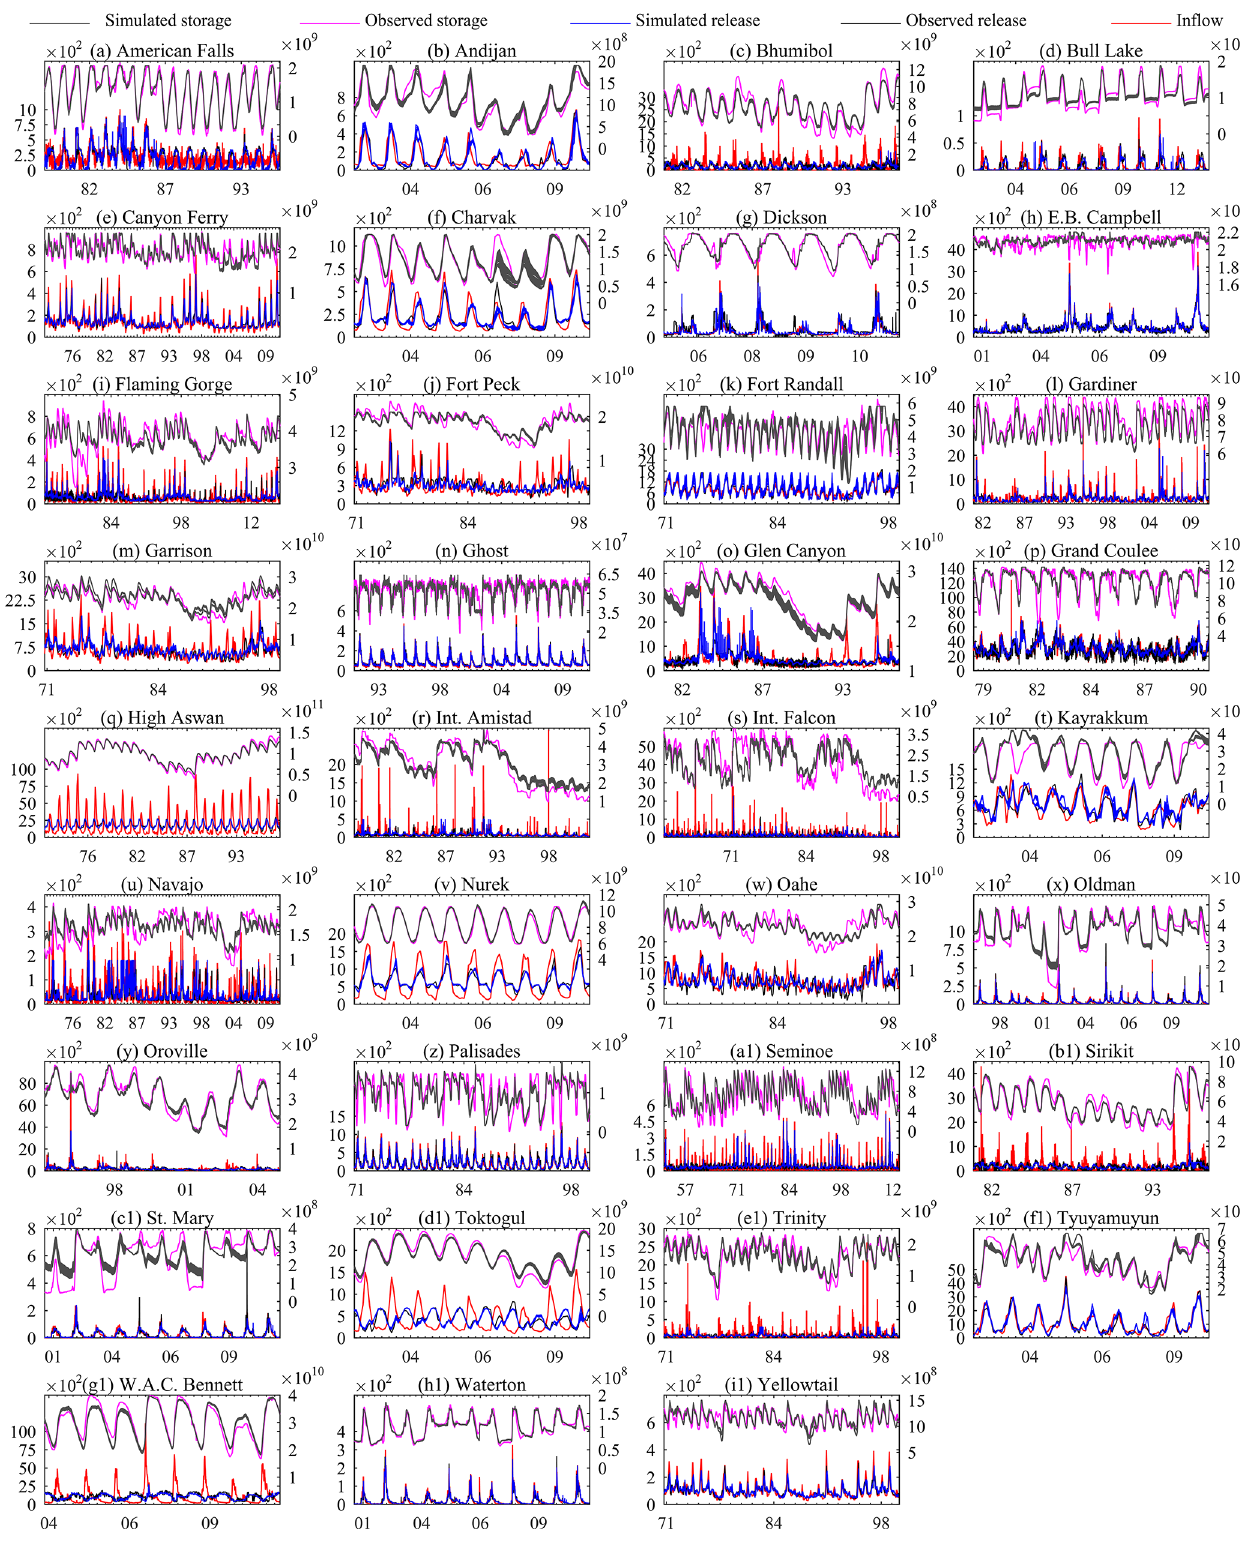
Figure 13. Daily and monthly reservoir simulations using DZTR model with a generalized parameterization; x axes show the month and year, the primary y axes show release (m 3 s − 1 ), and the secondary y axis shows storage (m 3